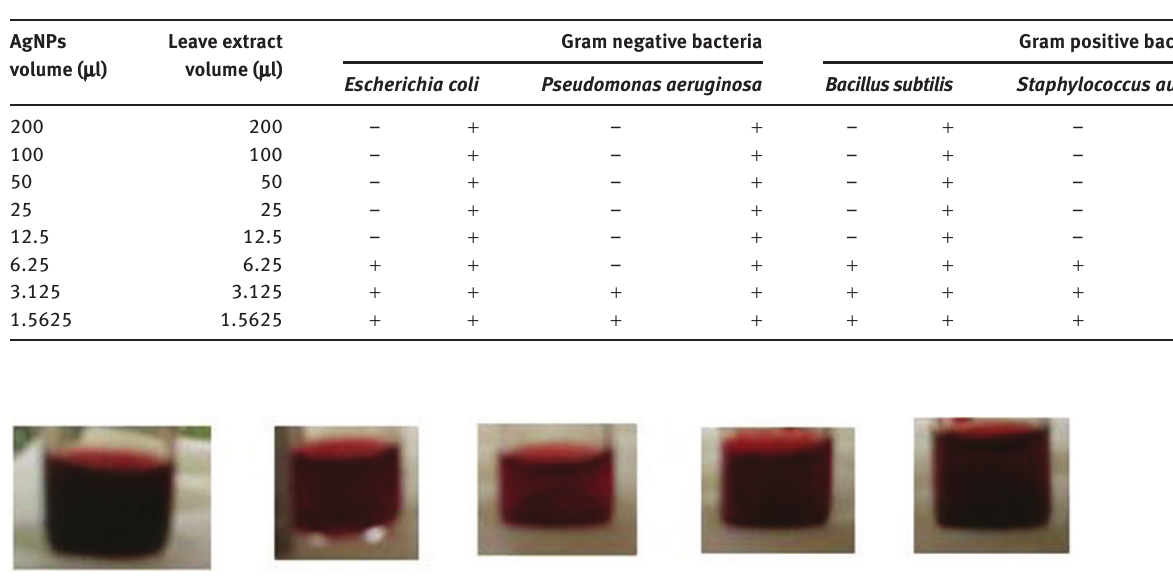
Table 2: Minimal inhibitory concentration of silver nanoparticles (AgNPs) and plant leaf extract were determined by micro-broth dilution method (growth of bacteria [ + ] and the inhibition of bacterial growth